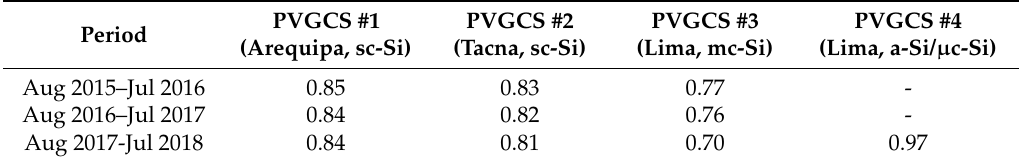
Table 4. Values of PR ,annual for PVGCS #1–#3 and PR DC,annual for PVGCS #4. Period